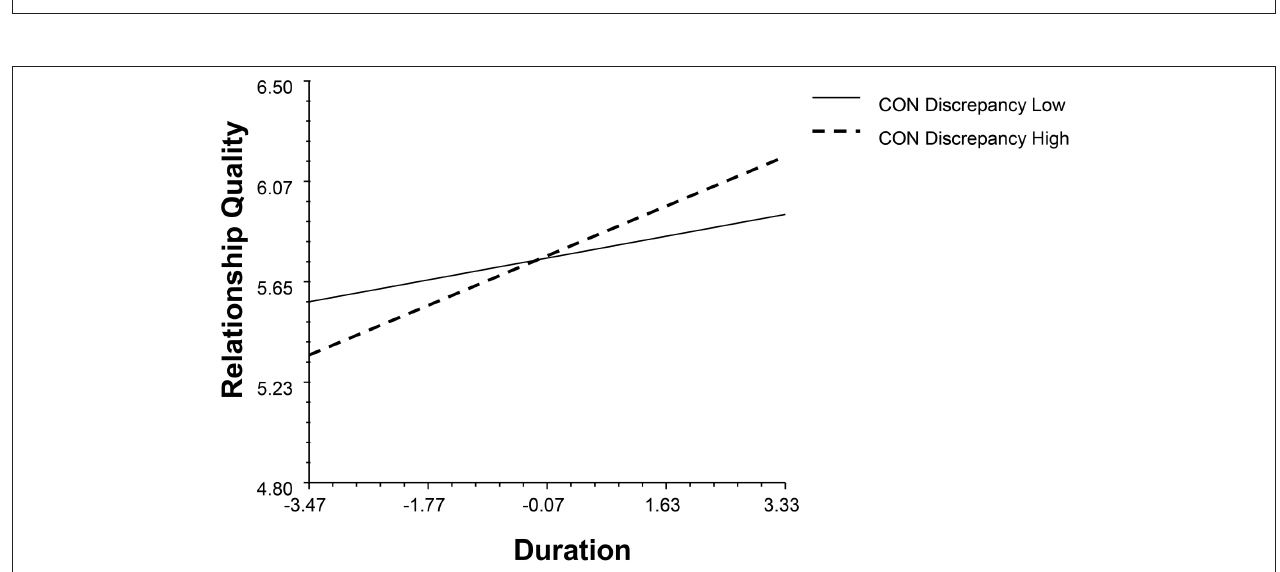
FIGURE 5 | The interaction between partner’s openness and duration.